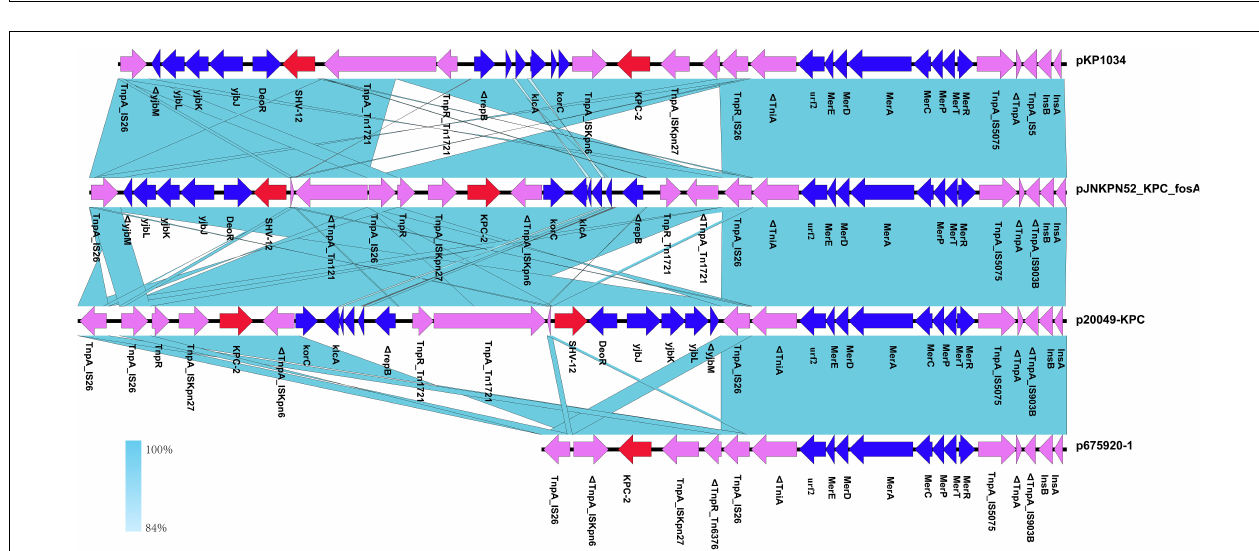
FIGURE 6 | Comparison of genetic context of the multidrug-resistant (MDR) region with related regions.